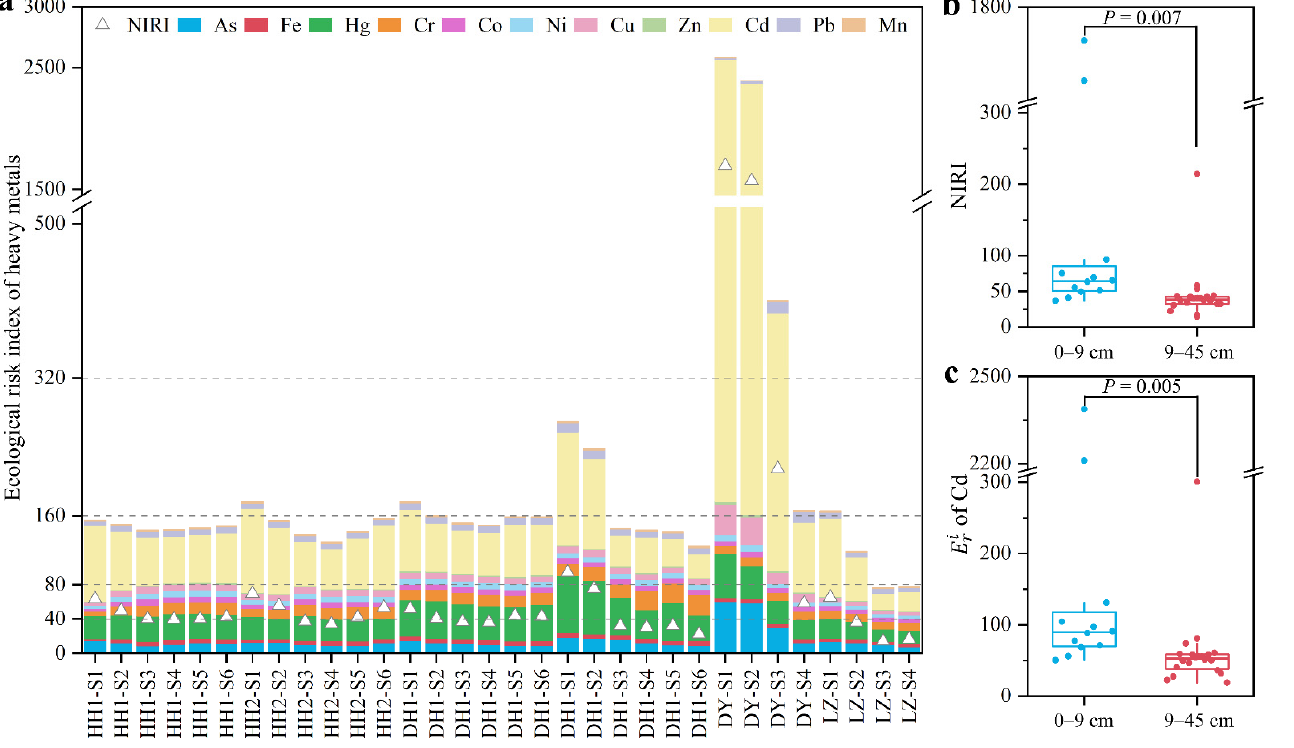
Figure 5. Potential ecological risk of heavy metals in sediment core: ( a ) NIRI and E i r values of heavy metals; ( b ) NIRI difference in heavy metals within sediments at 0–9 and 9–45 cm; and ( c ) E i r difference in Cd within sediments at 0–9 and 9–45 cm. The gray dotted line represents the threshold of different ecological risk levels of heavy metals: 40, 80, 160 and 320 represents moderate, considerable, high, and extremely high risk,